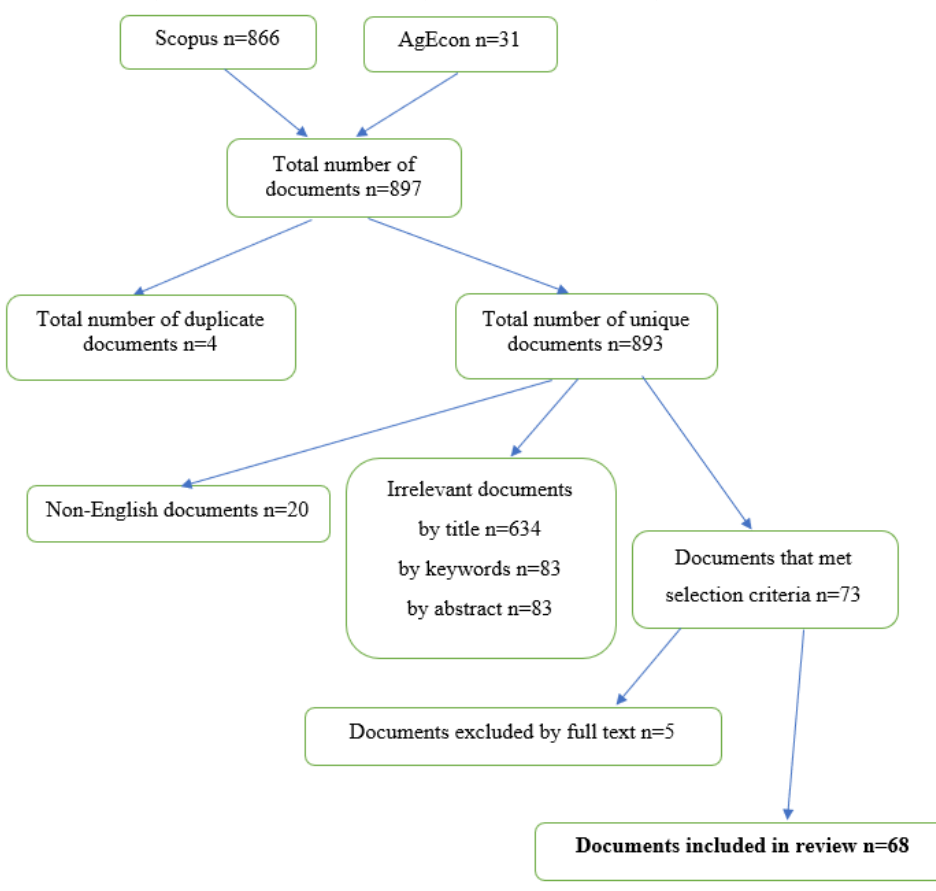
Figure 1. Flow diagram describing study selection. Source: authors’ elaboration.